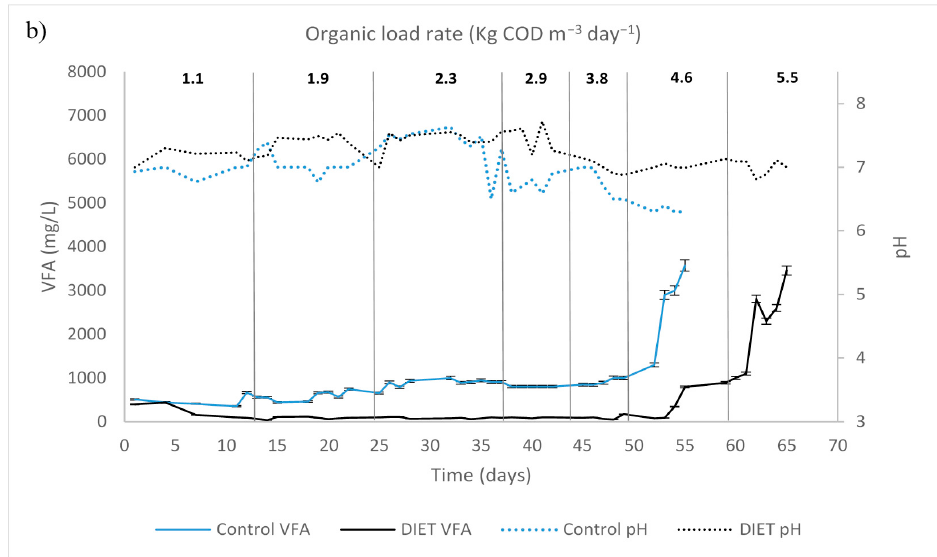
Figure 2. Upflow anaerobic sludge blanket startup and different organic load rate: ( a ) chemical oxygen demand; ( b ) volatile fatty acids (VFA) and pH.